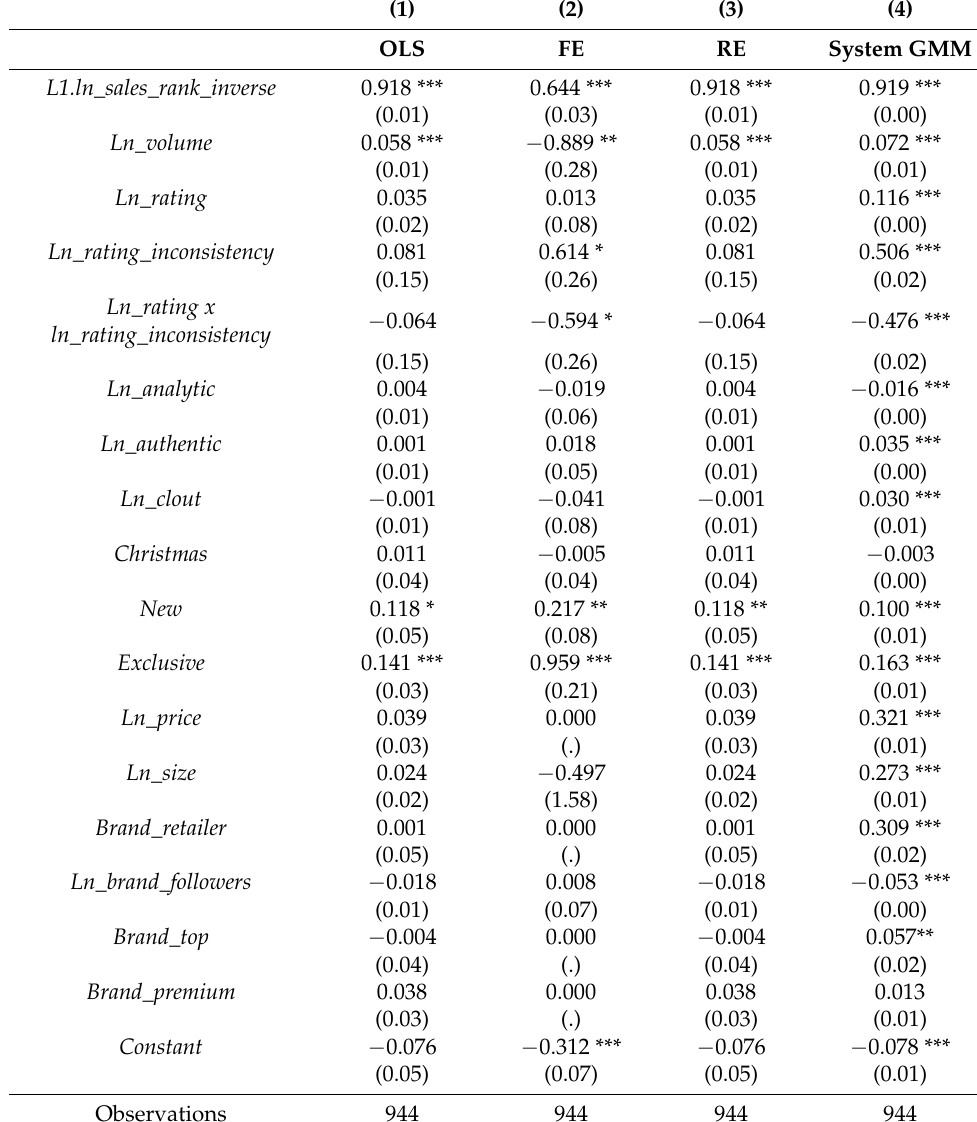
Table A1. All reviews—same probability of being viewed (case v 1